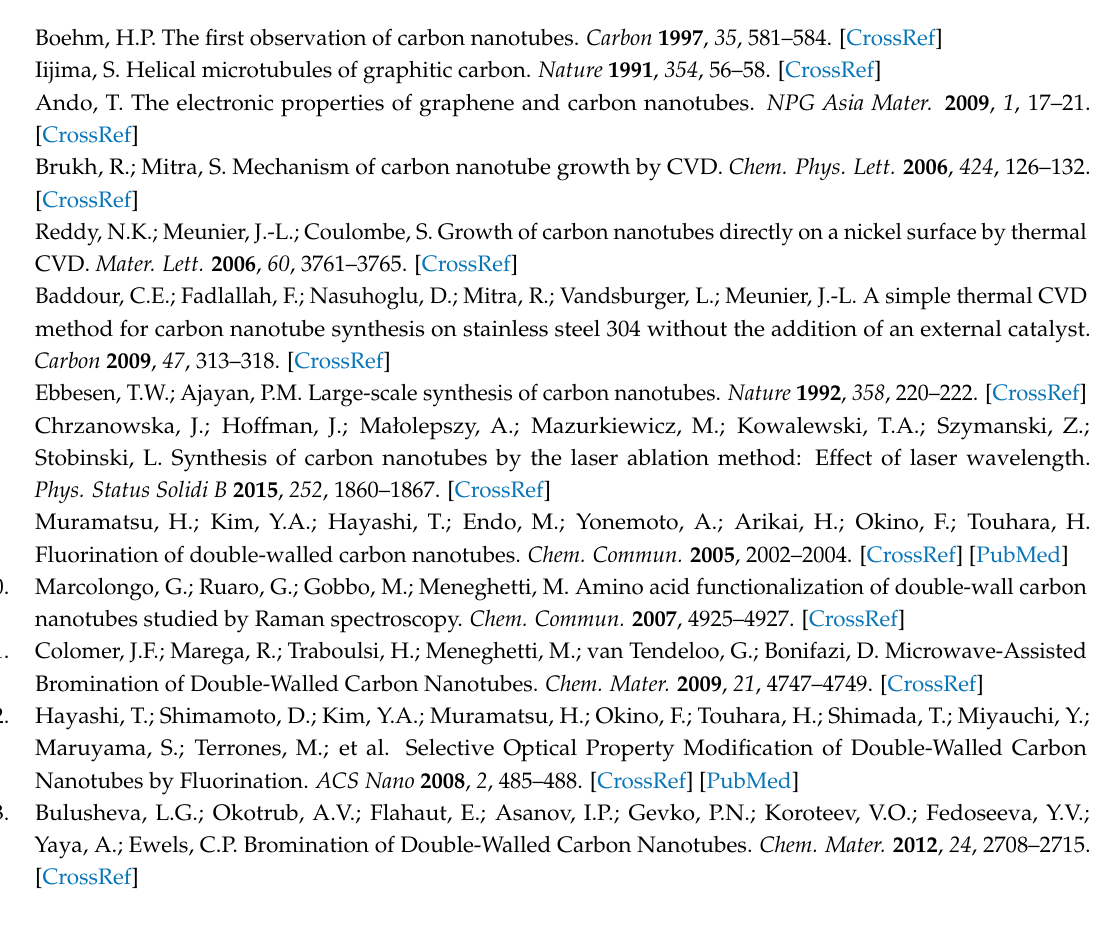
Figure S1: Comparison of MIES at range of temperatures (Kelvin); as the temperature drops the features amplify, Figure S2: Variation of AD and AN/RI dominance across the temperature range (Kelvin); AD dominates at lower temperatures, Figure S3: C 1s XP spectra of the SWCNT and DWCNT. The C1 s spectra are similar to those published for HOPG and characteristic for sp 2 hybridised